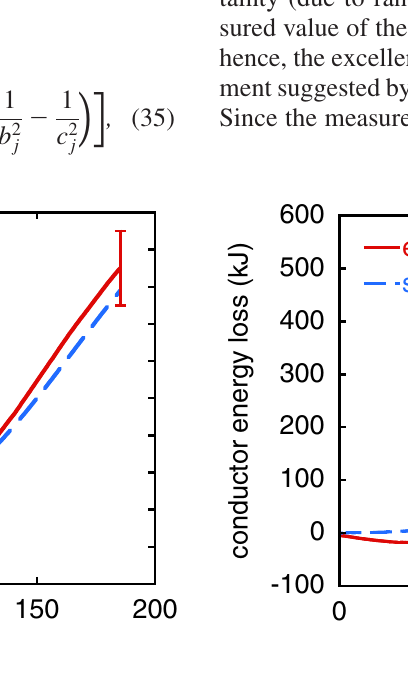
FIG. 8. (Color) Comparison of the measured conductor energy loss on Z-shot 589 with the prediction of the semianalytic model, as given by Eq. (35). The conductor system used as the load on this shot is that illustrated by Fig. 3. The plot includes a representative error bar.